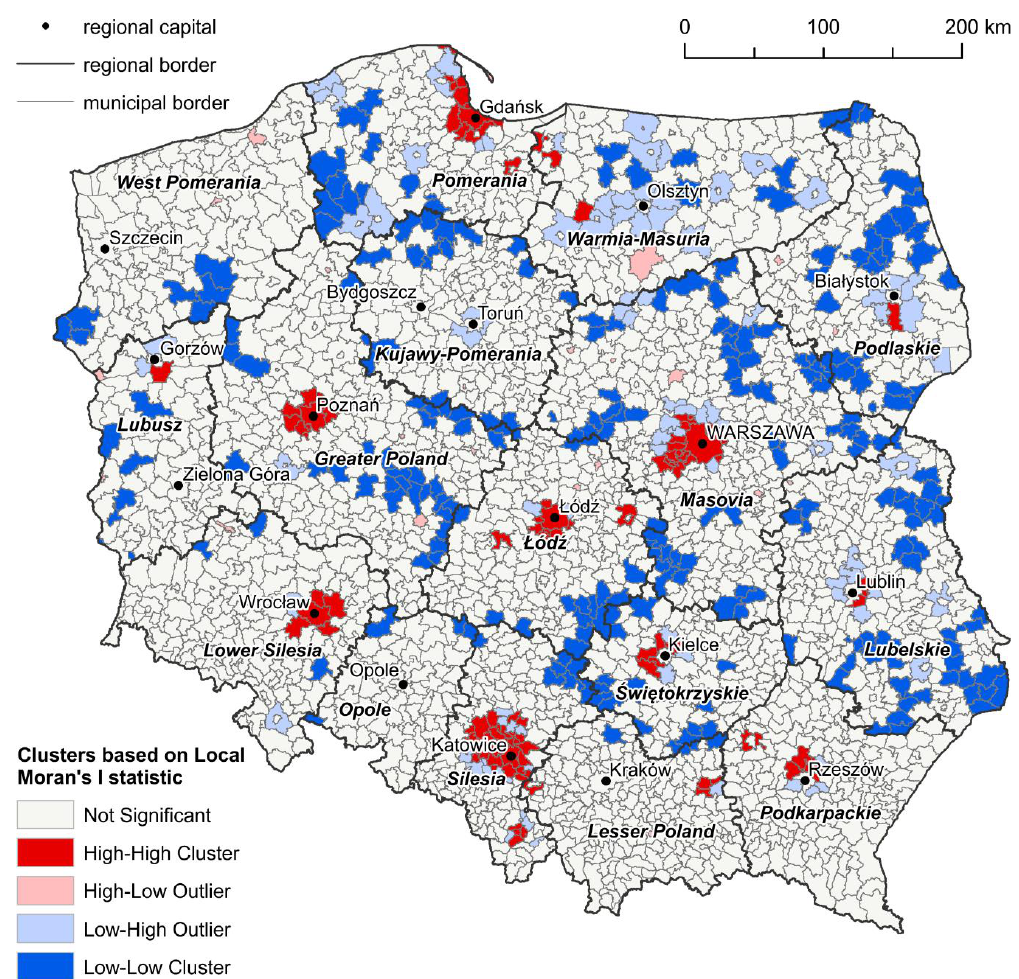
Figure 2. Hot spots and cold spots of spatial distribution of total EU support per square km in Poland, in the years 2012–2018.